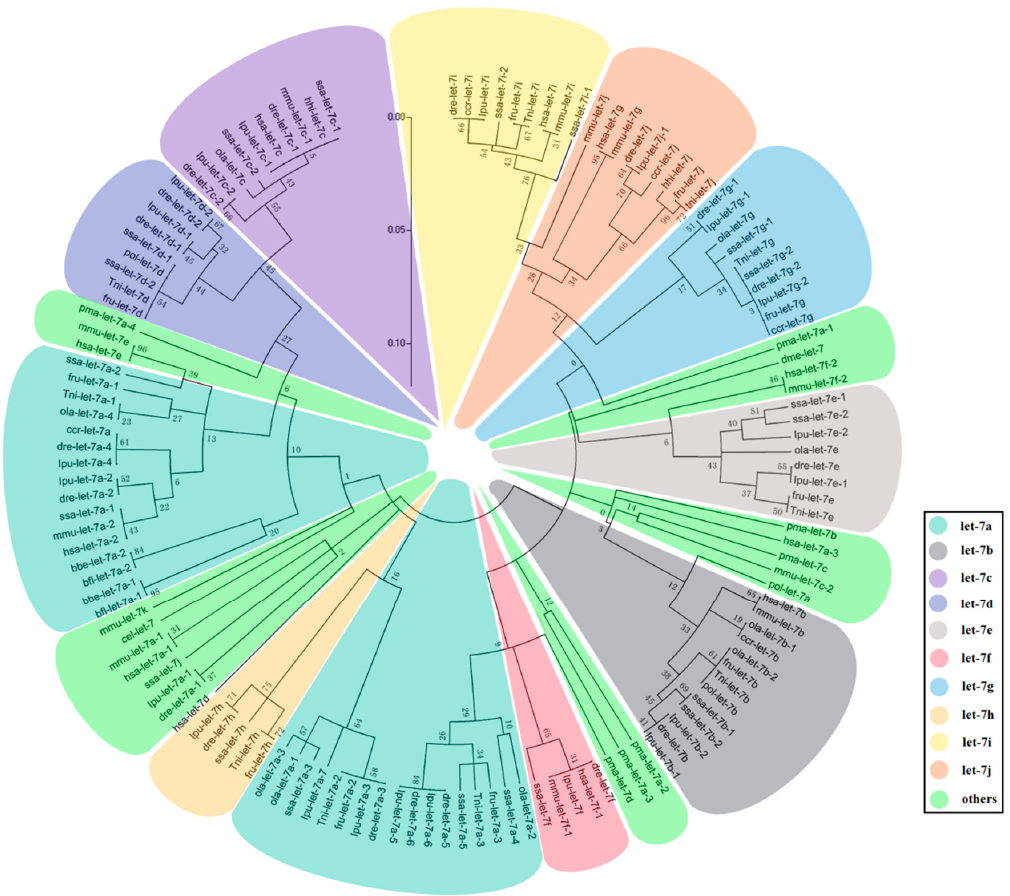
Figure 3. The phylogenic tree of let-7 miRNAs in 16 species including nine fish species ( Danio rerio -dre, Oryzias latipes -ola, Fugu rubripes -fru, Tetraodon nigroviridis -tni, Ictalurus punctatus -ipu, Cyprinus carpio -cca, Paralichthys olivaceus -pol, Hippoglossus hippoglossus -hhi, and Salmo salar -ssa), five out-group species ( Homo sapiens -has, Mus musculus -mmu, Petromyzon marinus -pma, Drosophila melanogaster -dme, and Caenorhabditis elegans -cel) as well as two species considered to be the ancestors of fish ( Branchiostoma floridae -bfl and B. belcheri -bbe).